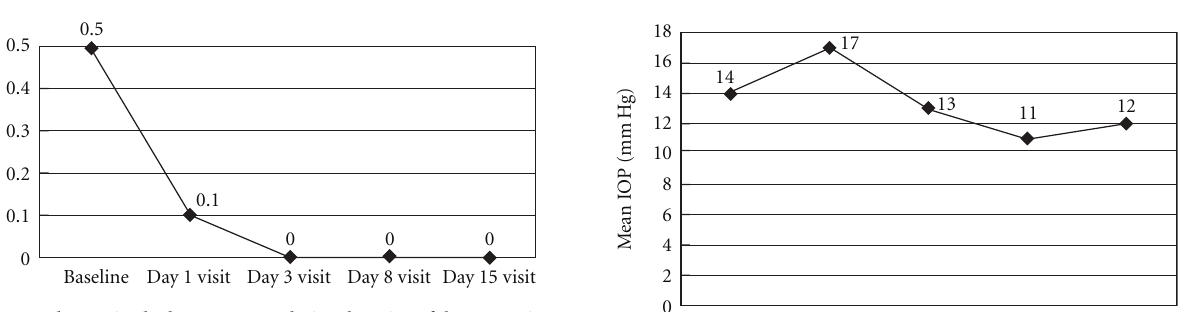
Figure 1: Change in the best-corrected visualacuity of the operative eye before and after treatment.